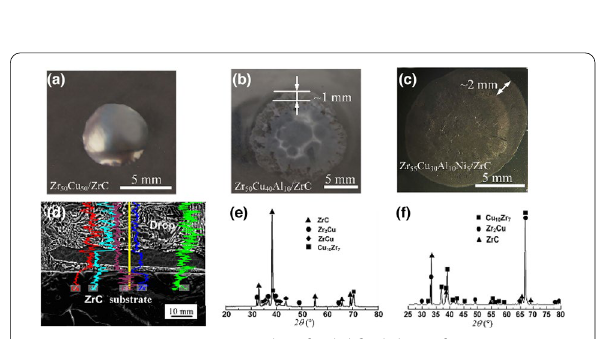
Figure 7 Top-view macrographs of solidified drops for ( a ) Zr 50 Cu 50 / ZrC, ( b ) Zr 50 Cu 40 Al 10 /ZrC, and ( c ) Zr 55 Cu 30 Al 10 Ni 5 /ZrC, ( d ) typical cross-sectional interface of Zr 55 Cu 30 Al 10 Ni 5 /ZrC, and ( e ) and ( f ) X-ray diffraction results obtained for PFs in Zr 50 Cu 40 Al 10 /ZrC and Zr 55 Cu 30 Al 10 Ni 5 /ZrC,